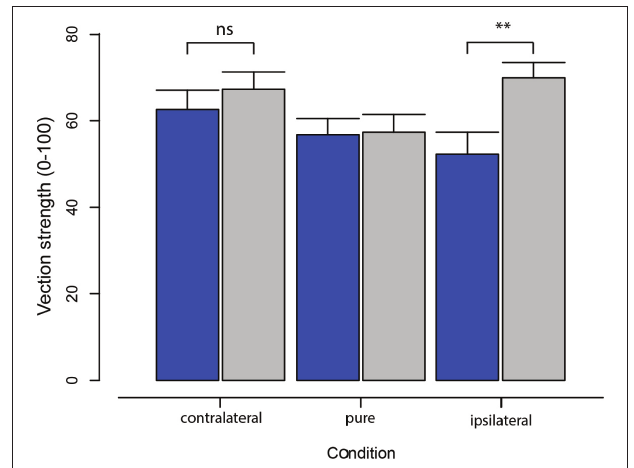
FIGURE 2 | Mean and standard errors for vection strength ratings obtained in each of the three radial flow display conditions (contralateral, pure, ipsilateral) with either active (blue) or passive (gray) viewing. Note the larger increase in vection strength during ipsilateral oscillation for passive compared with active viewing of the same visual information. Note that the difference in vection strength between active and passive conditions using ipsilateral synchronization (**) was not significant when using contralateral synchronization